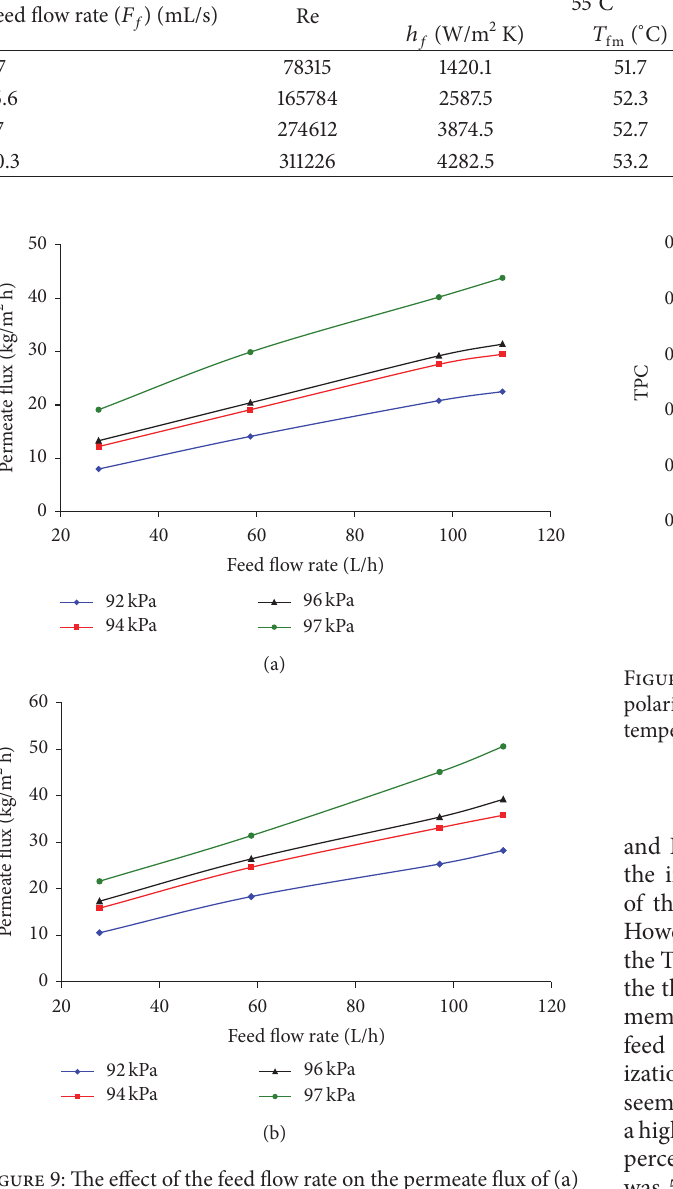
Figure 9: The effect of the feed flow rate on the permeate flux of (a) PVDF and (b) PTFE membranes at different vacuum degrees, with a feed temperature of 65 ∘ C and feed concentration of 35,000 mg/L.